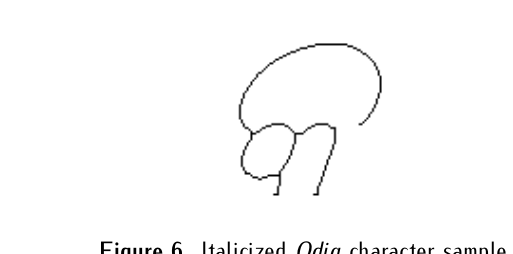
Figure 6. Italicized Odia character sample.